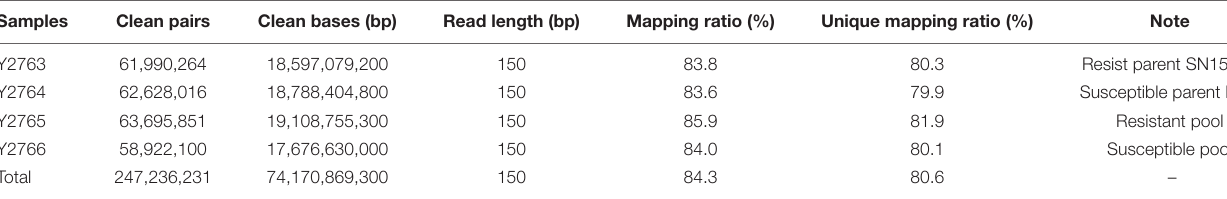
TABLE 1 | Information of bulked segregant RNA-Seq (BSR-Seq) data. Samples Clean pairs Clean bases (bp)